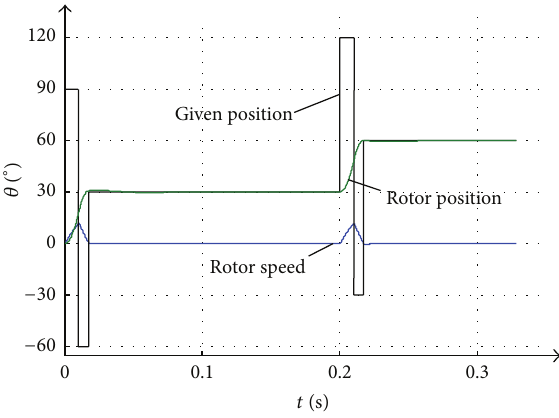
Figure 10: Position and speed curve under maximum torque.